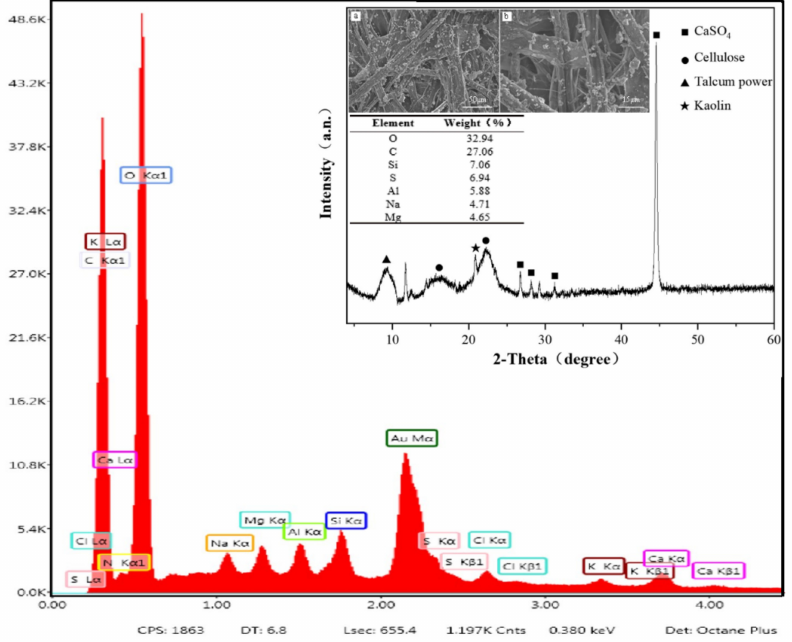
Figure 6. SEM-EDS and XRD of the paper. ( a , b ) are magnified 500 and 1500 times, respectively.